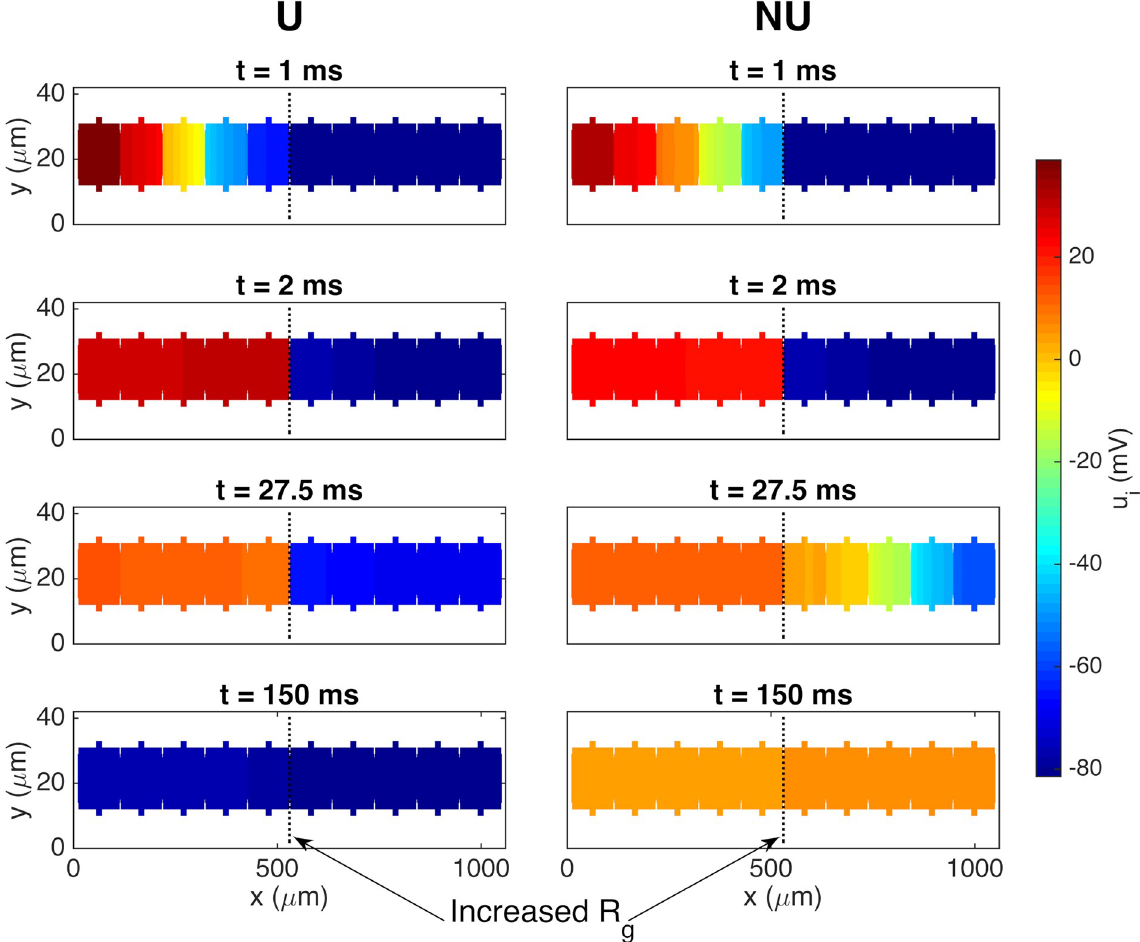
Fig 12. Illustration of the propagating wave being blocked for the U case but not for the NU case. The figure shows the intracellular potential in the plane at the center of the domain in the z -direction at four points in time for the case with a uniform (U) and a non-uniform (NU) distribution of sodium channels. The default gap junction resistance is increased by a factor of 70 from 0.0045 k O cm 2 to 0.315 k O cm 2 between the fifth and sixth cells. The remaining parameter values used in the simulations are given in Table 1, except that the time step is set to Δ t = 0.01